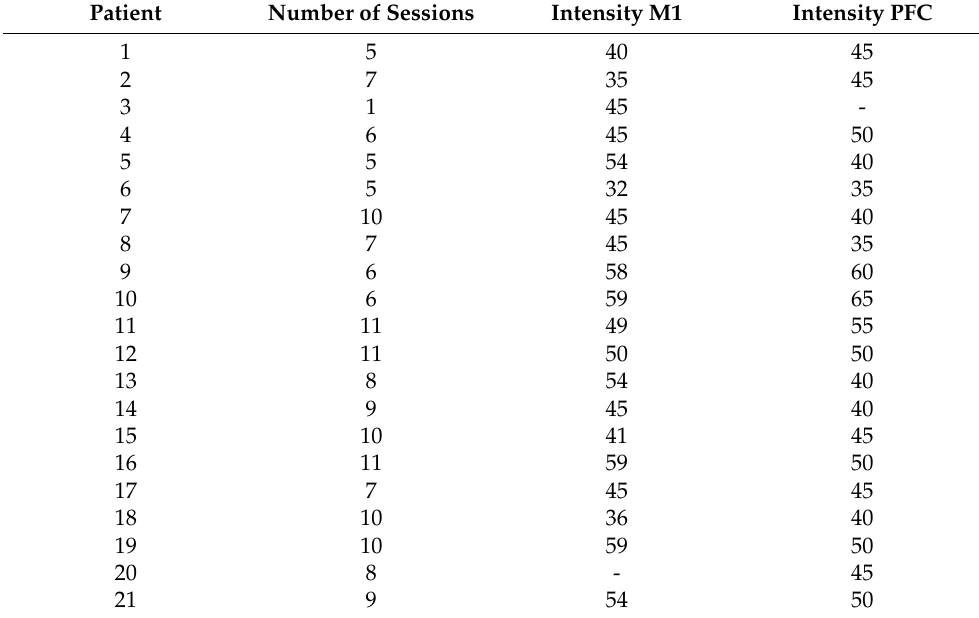
Table 2. This table shows the number of sessions as well as the intensity parameters (percent of stimulator output) of M1 and PFC stimulation. Please note that the stimulation intensity was calculated according to the manufacturer’s guidelines based on resting motor threshold but was adjusted if it was too uncomfortable (15 out of 21